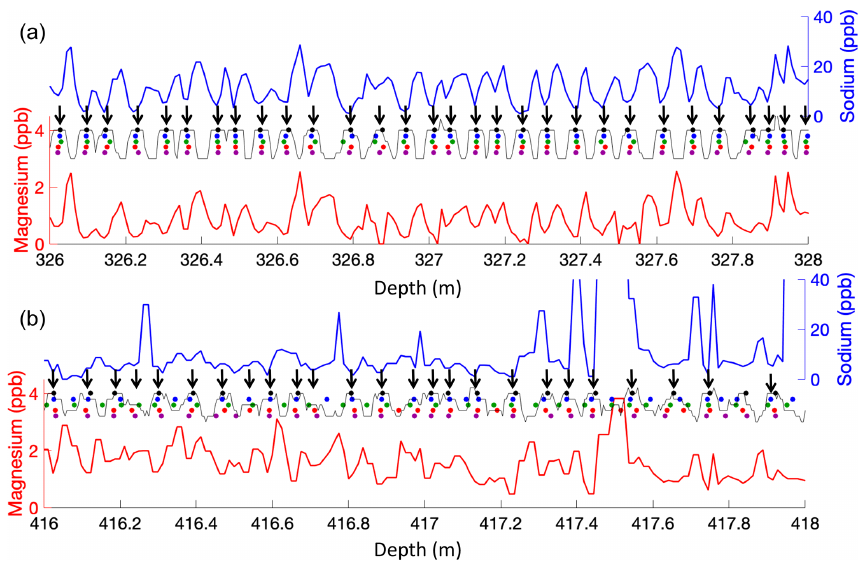
Figure 6. Representative sections of annual layer pick positions compared with magnesium (red) and sodium (blue) concentrations. Each interpreter is represented by a different color circle. Certain sections have excellent agreement among interpreters making reconciliation trivial (a) , whereas other sections have poorly defined annual signals and associated disagreement among interpreters (b) . The black line depicts the sum of all picks within ± 2cm; black arrows depict the final positions of the reconciled 1 January annual layer picks.